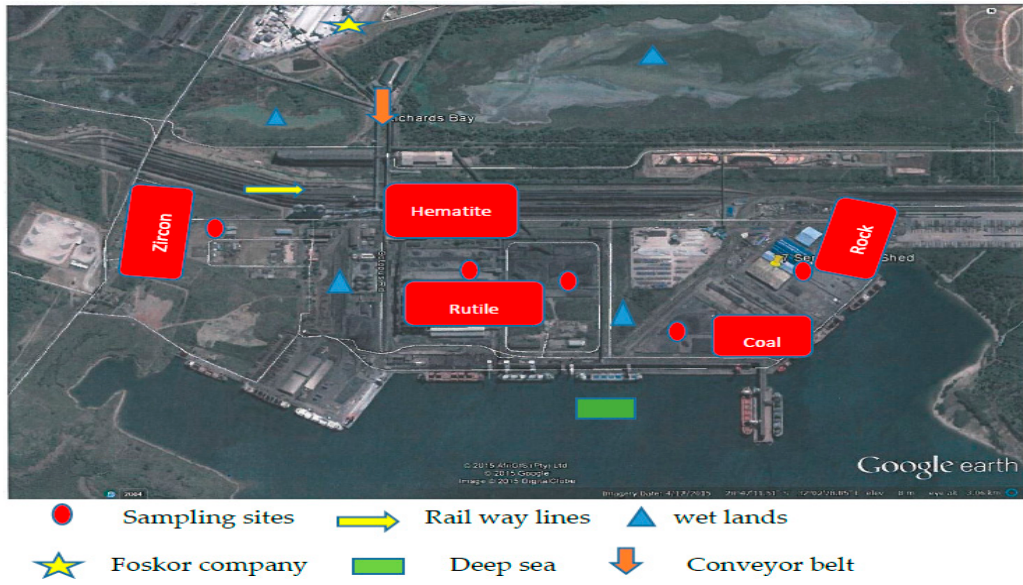
Figure 1. Arial view of the port in the Richards Bay area [14].